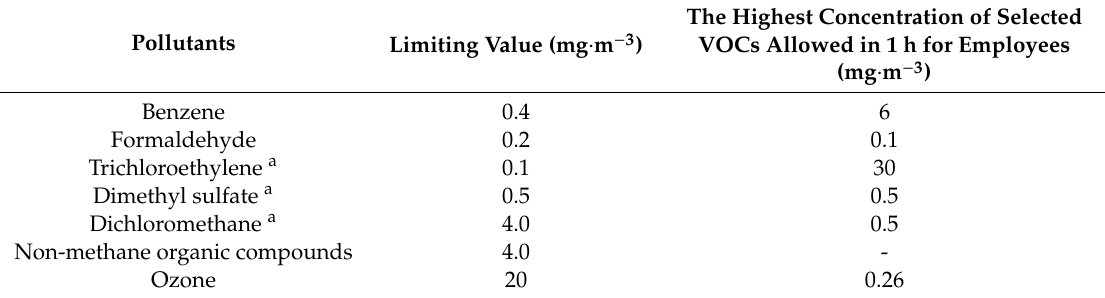
Table 1. The extreme emission value of volatile organic compounds (VOCs) on the boundary of factories and the highest concentration of selected VOCs allowed in 1 h for employees [13].